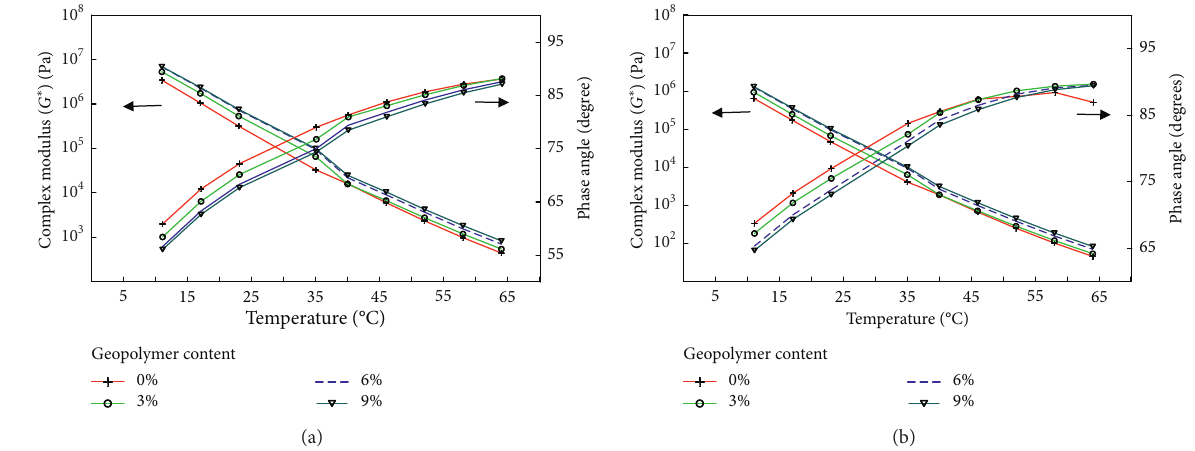
Figure 8: Isochronal plots of the complex modulus and phase angle at (a) 1Hz and (b) 0.1 Hz.